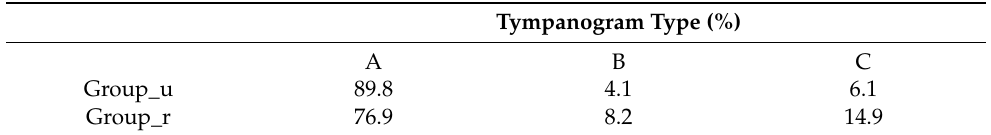
Table 1. Percentage of the type of tympanogram in the examined ears depending on the child’s place of residence. Group_u—urban; Group_r—rural.